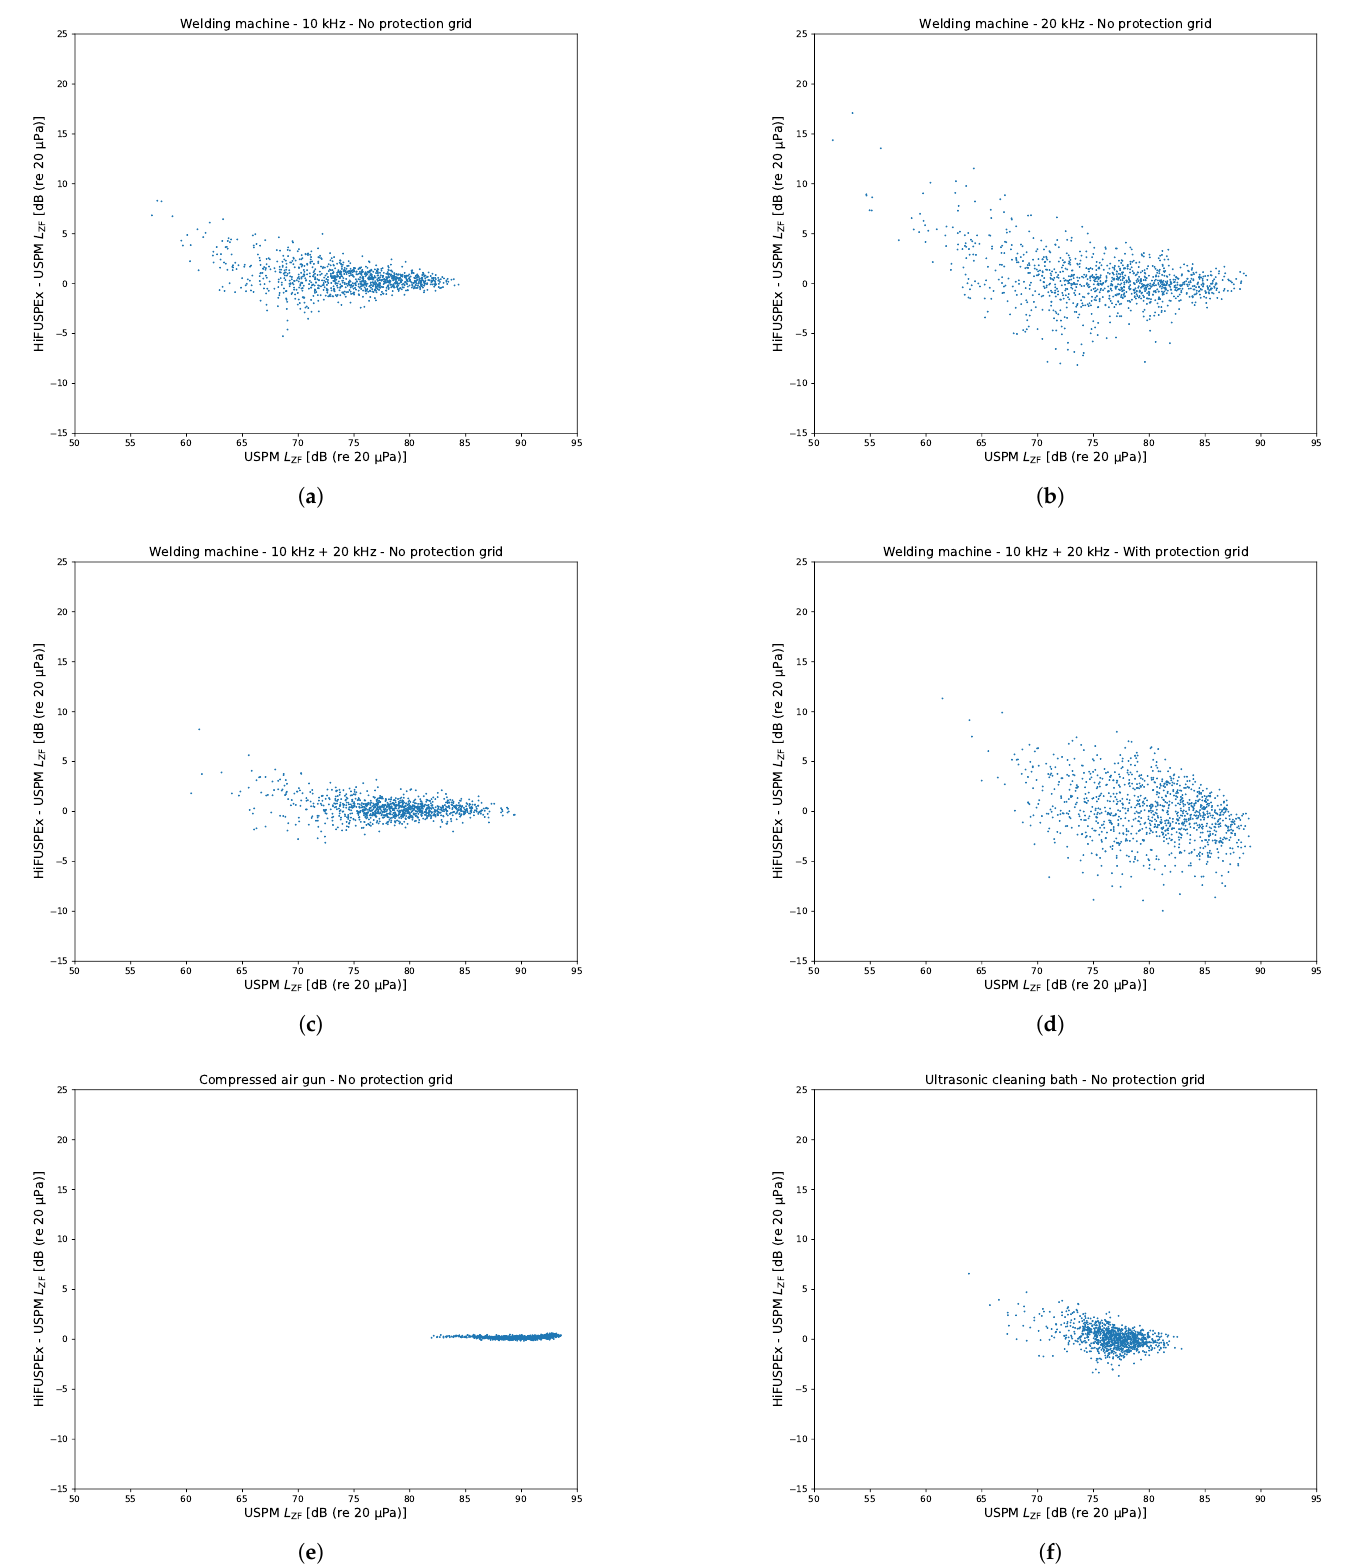
Figure 17. HiFUSPEx deviation from USPM for the selected cases: ( a ) welding machine − 10 kHz (no protection grid); ( b ) welding machine − 20 kHz (no protection grid); ( c ) welding machine − 10 kHz + 20 kHz (no protection grid); ( d ) welding machine − 10 kHz + 20 kHz (with protection grid); ( e ) compressed air gun (no protection grid); and ( f ) ultrasonic cleaning bath (no protection